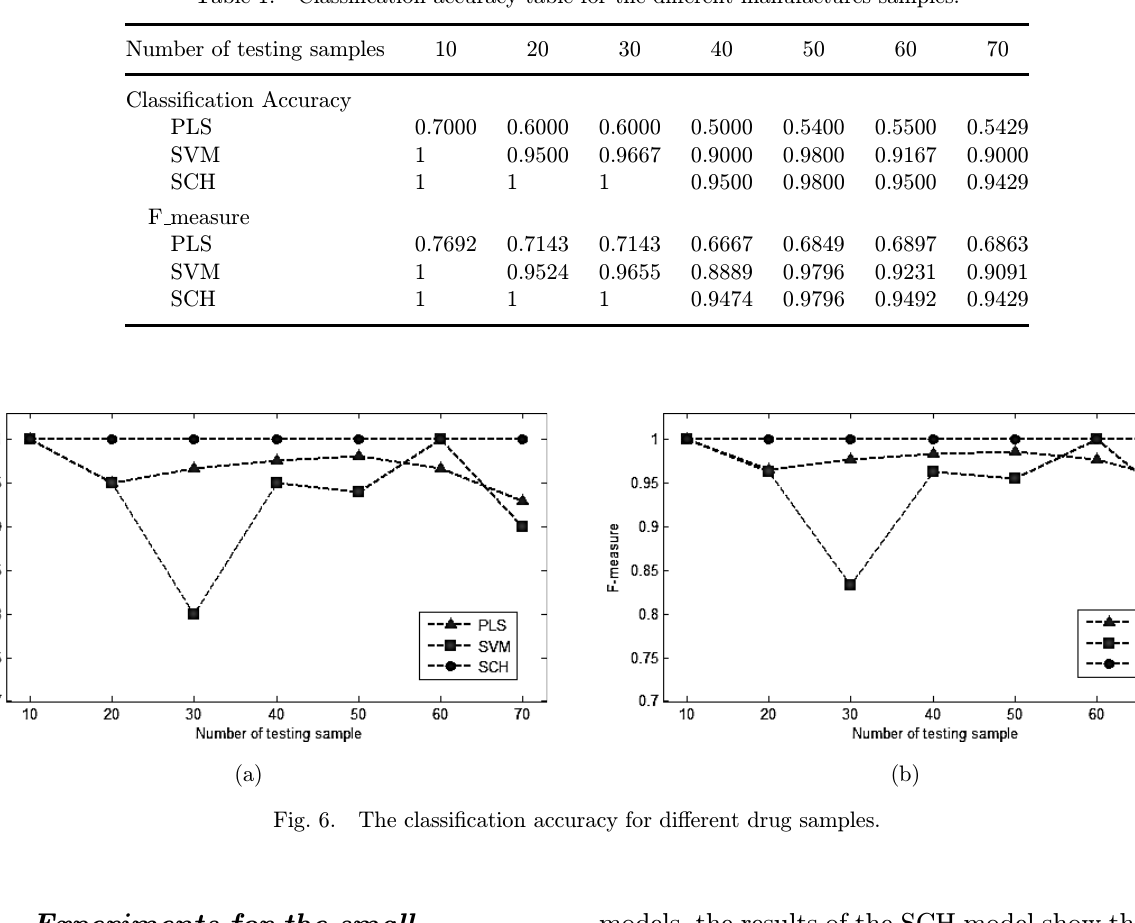
Table 1. Classi¯cation accuracy table for the di®erent manufactures samples.